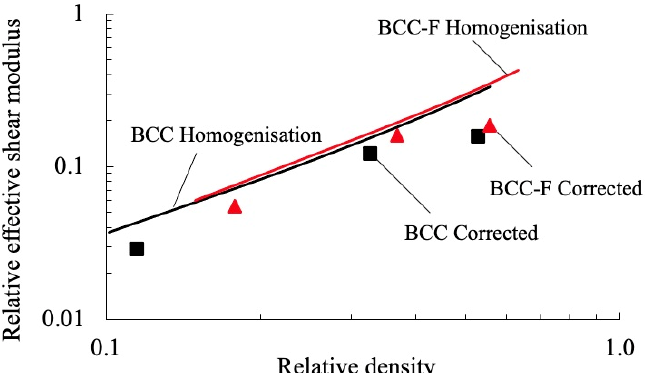
Figure 11. The corrected relative effective shear moduli and the corresponding numerically homogenised relative effective shear moduli of the BCC lattice and the BCC-F lattices at different relative densities (log–log scale).